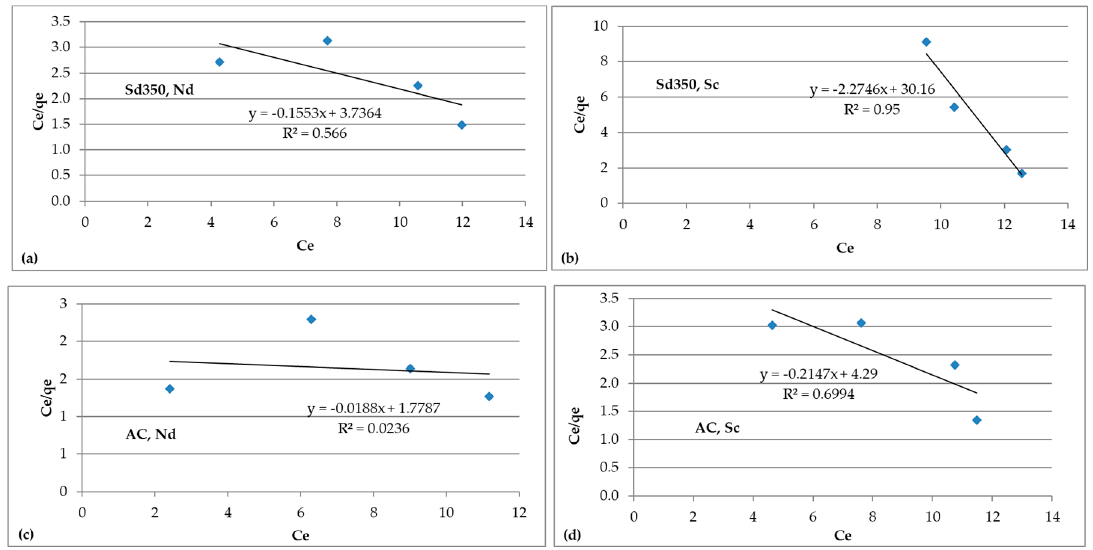
Figure 10. Langmuir isotherms for Nd and Sc adsorption on biochar Sd350 ( a,b ) and AC ( c,d ).